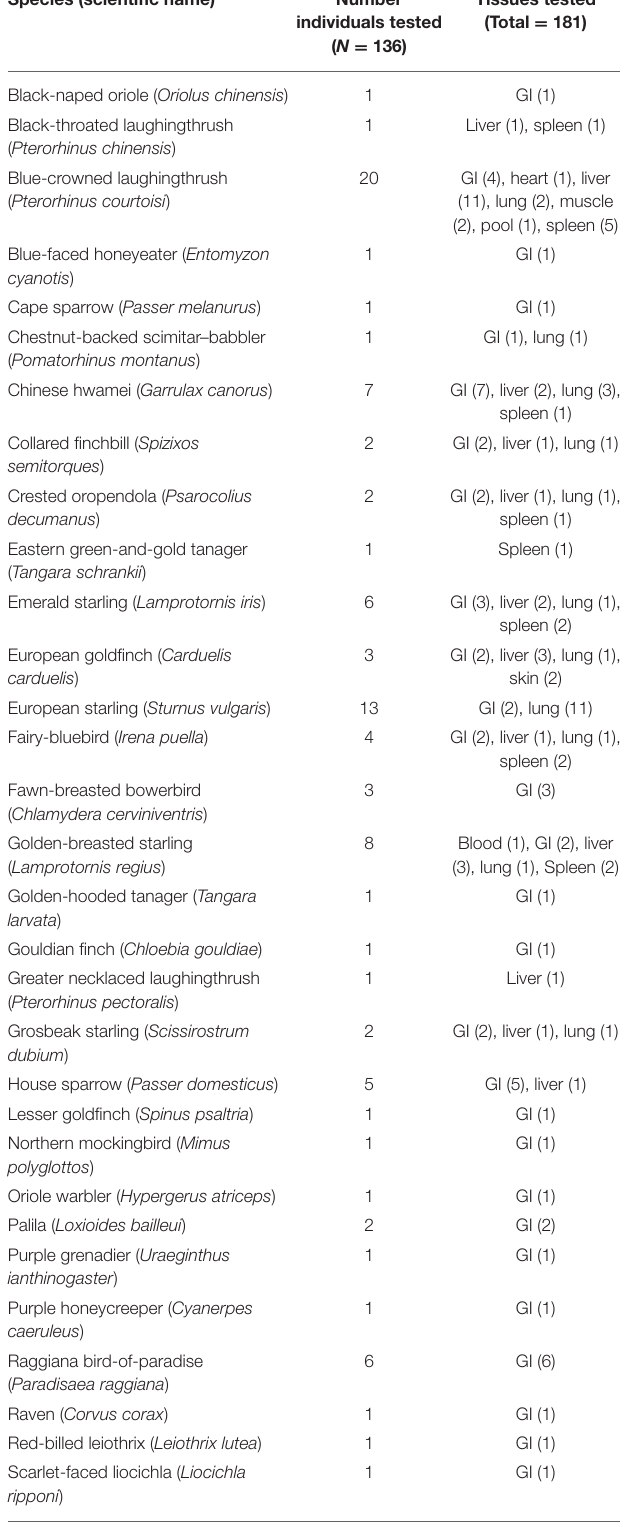
TABLE 1 | Avian host species and associated tissue samples represented by Isospora sequences. Species (scientific